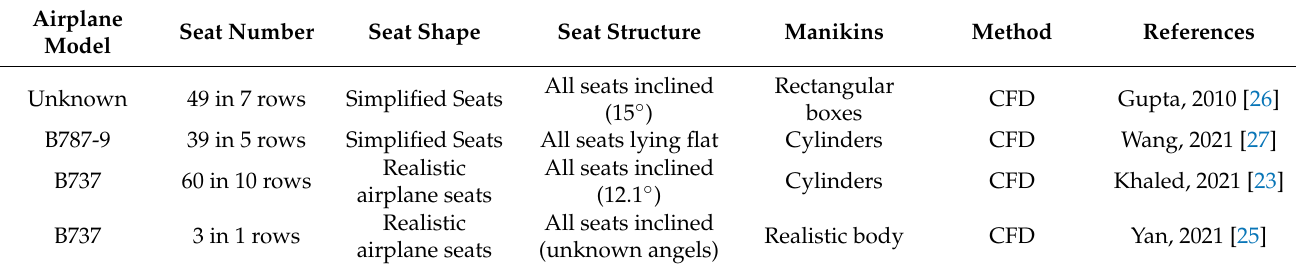
Table 2. Summary of inclined seats in representative published studies.